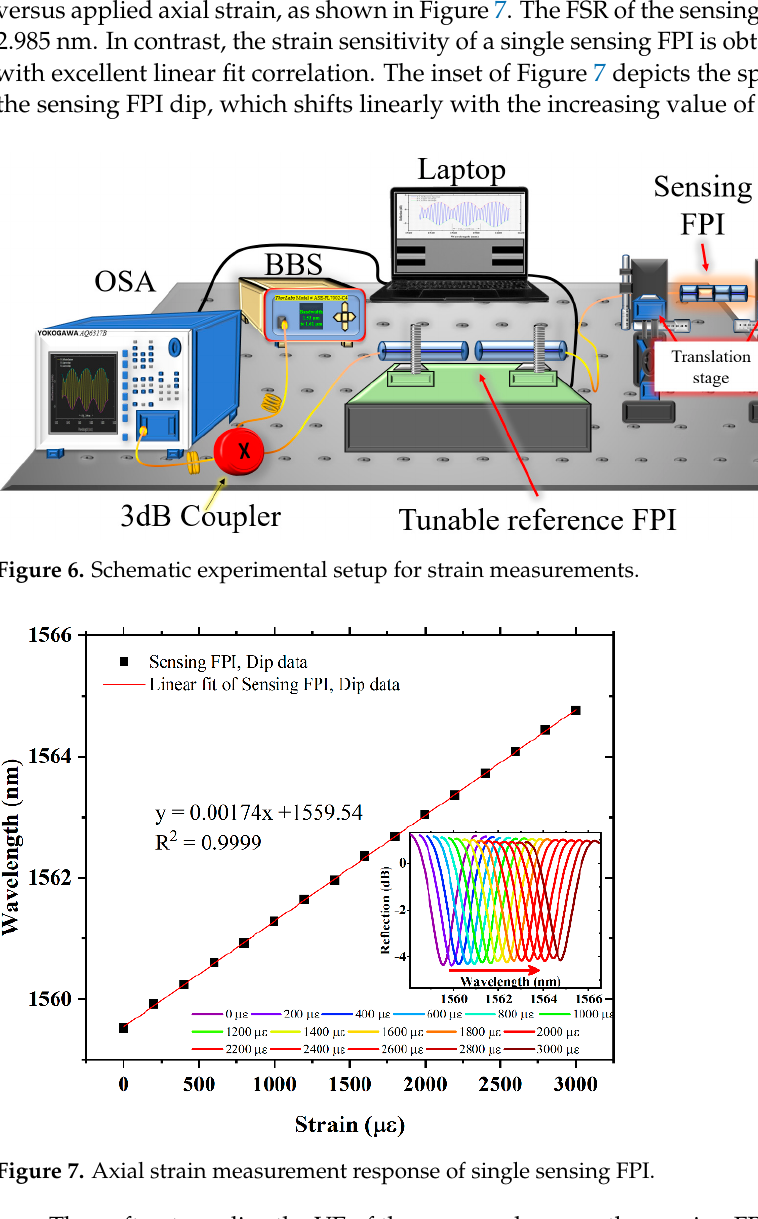
Figure 7. Axial strain measurement response of single sensing FPI.